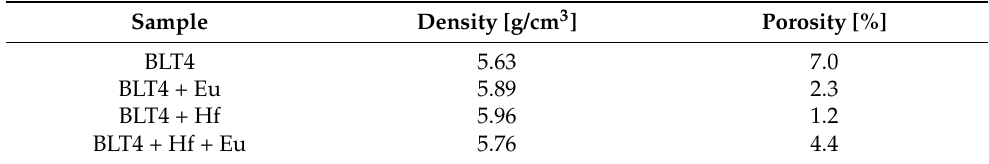
Table 1. Density and porosity of discussed ceramics.